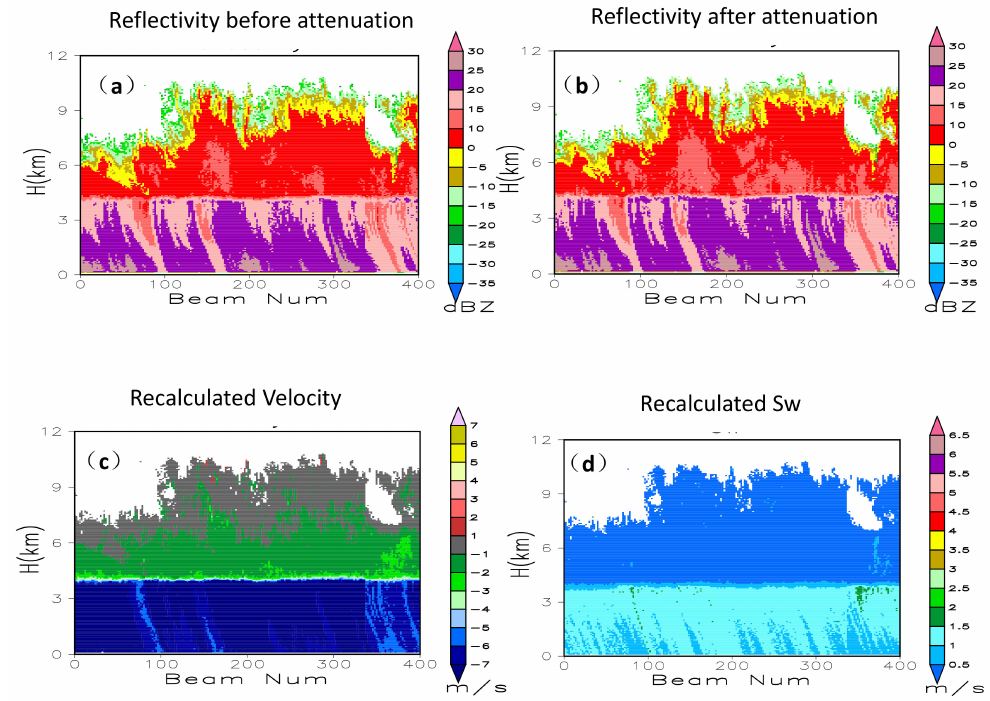
Figure 2. Recalculated reflectivity before ( a ) and after ( b ) attenuation correction, ( c ) radial velocity, and ( d ) spectrum